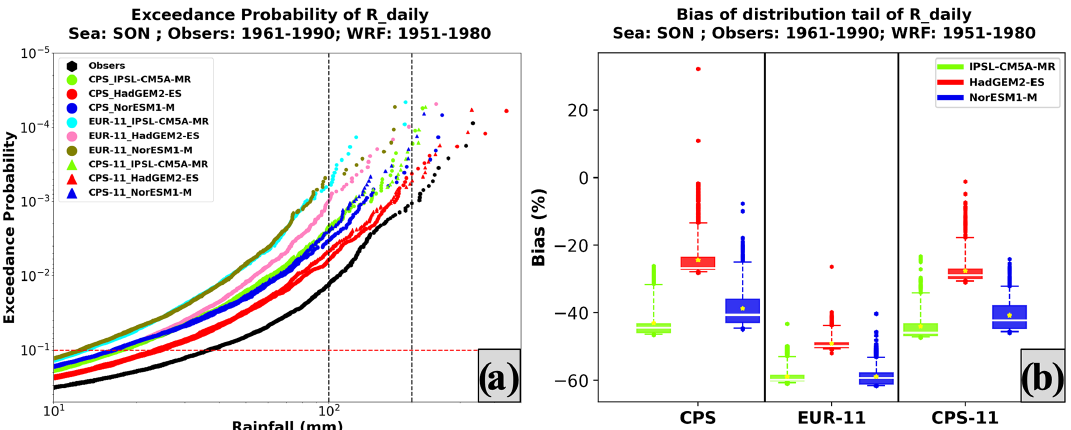
Figure 4. Exceedance probability distribution (a) for daily rainfall in the autumn from in situ observations (1961–1990) and all simulations (1951–1980). The bias (b) of 10% in the tail of the distribution from each simulation against in situ observations. The red dotted line in panel (a) denotes the exceedance probability of 0.1, above which the simulated rainfall values are used to estimate the bias of the distribution tail in panel (b) .